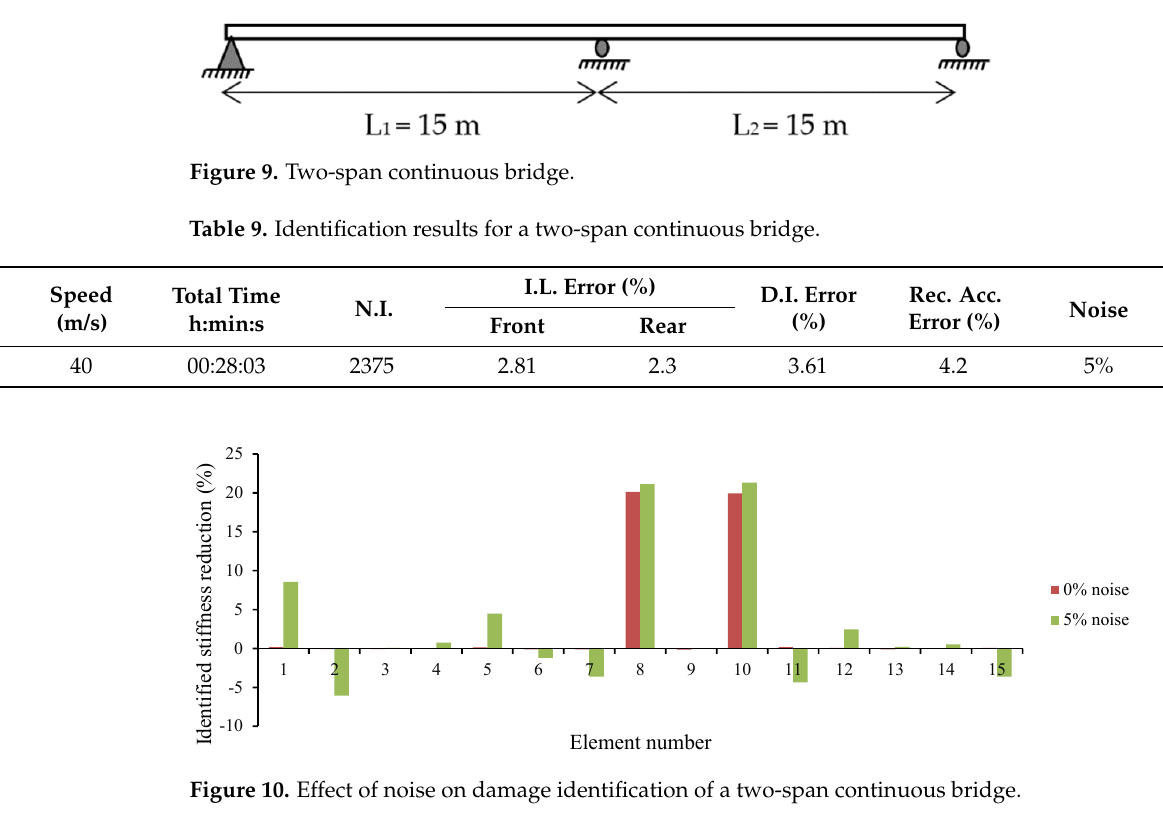
Figure 11. Load identification at 5% noise; ( a ) front load, ( b ) rear load.